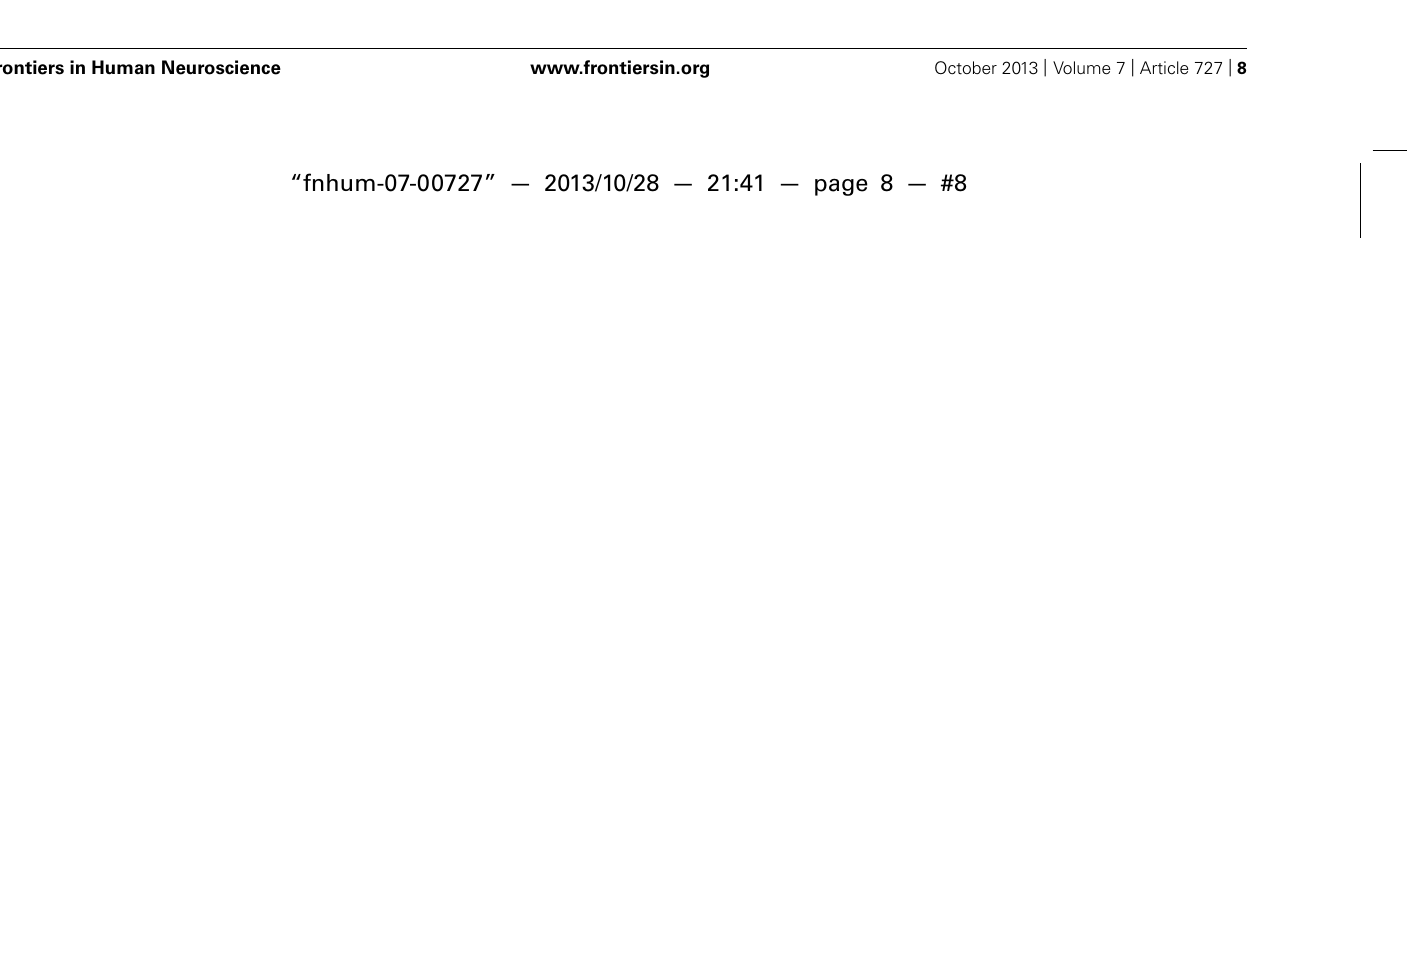
antipsychotic medication. SPMs are thresholded at p < 0.05, FWE-corrected at cluster level and superimposed on a single subject high resolutionT1 image. Color coding (red > yellow) represents t -values ranging from 4 to